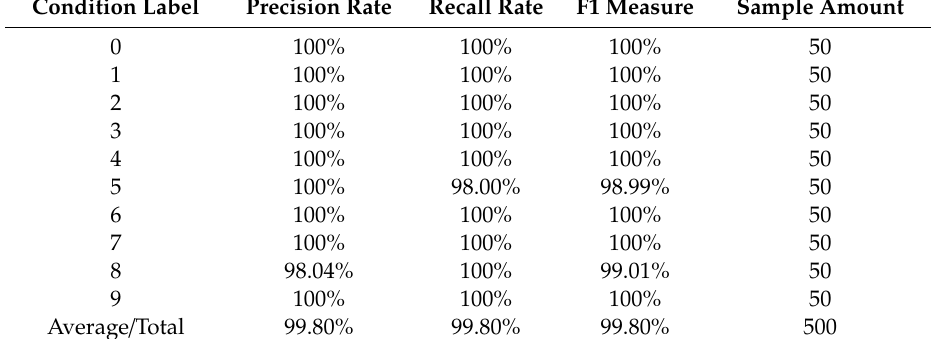
Table 4. Test results of the proposed GL-mRMR-SVM model.